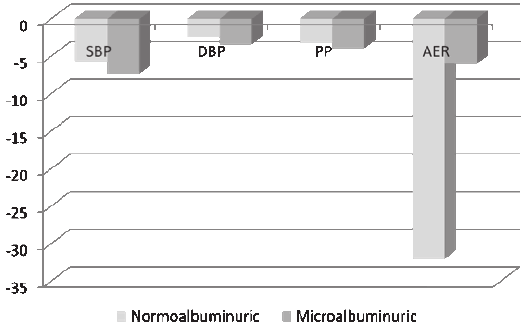
Figure 2. Mean blood pressure (mmHg) and urinary albumin excretion (UAE, mg/24h) reductions. Changes in BP